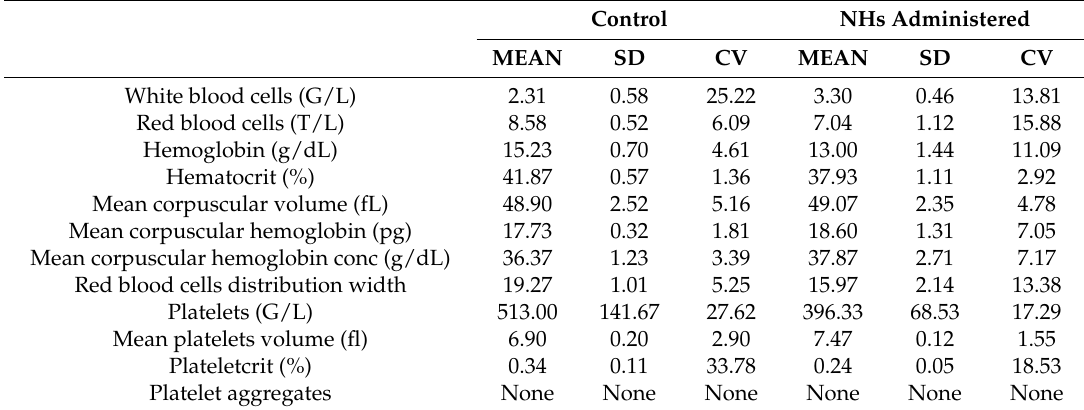
Table 2. Values of the standard blood test parameters.